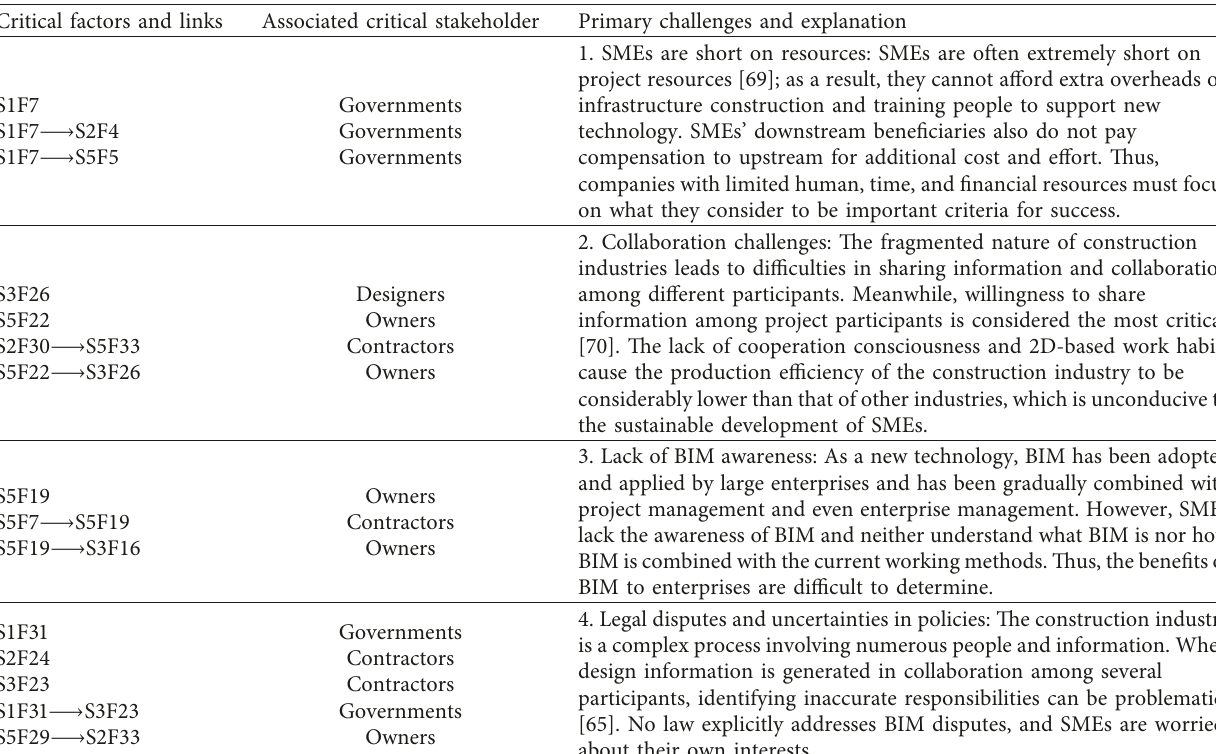
Table 5: Critical factors and challenges for BIM adoption in